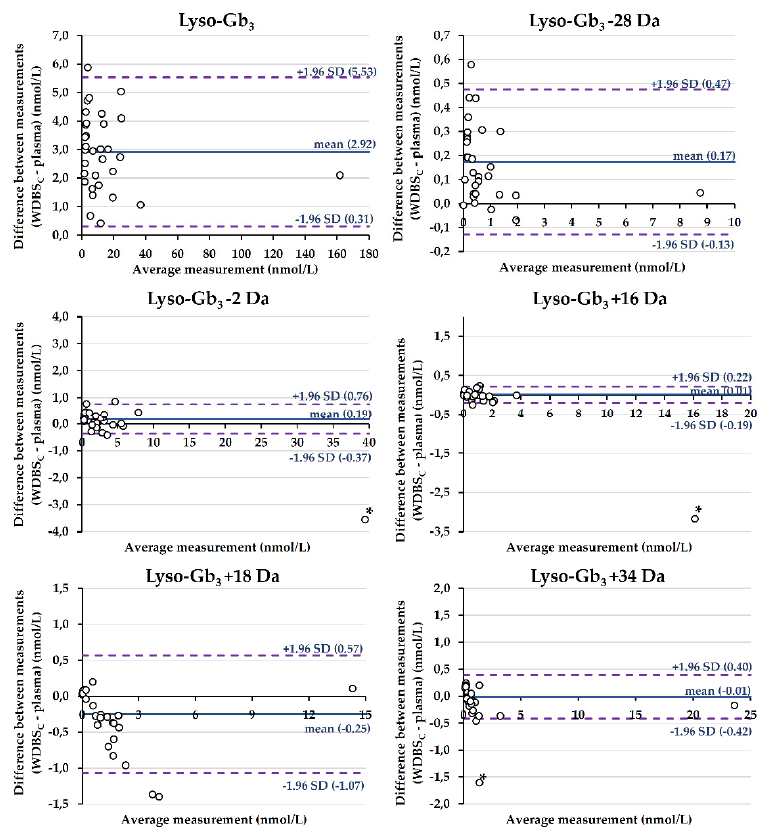
Figure 2. Bland–Altman analyses between lyso-Gb 3 and related analogue measurements in plasma and in DBSs collected using Whatman-GE 903 filter papers (capillary blood) ( n = 32 participants). Mean differences are shown by solid lines, while the dashed lines represent the limits of agreement. For lyso-Gb 3 − 2 Da, lyso-Gb 3 +16 Da, and lyso-Gb 3 +34 Da, an outlier (*) was excluded from the calculations of the mean difference and 95% limits of